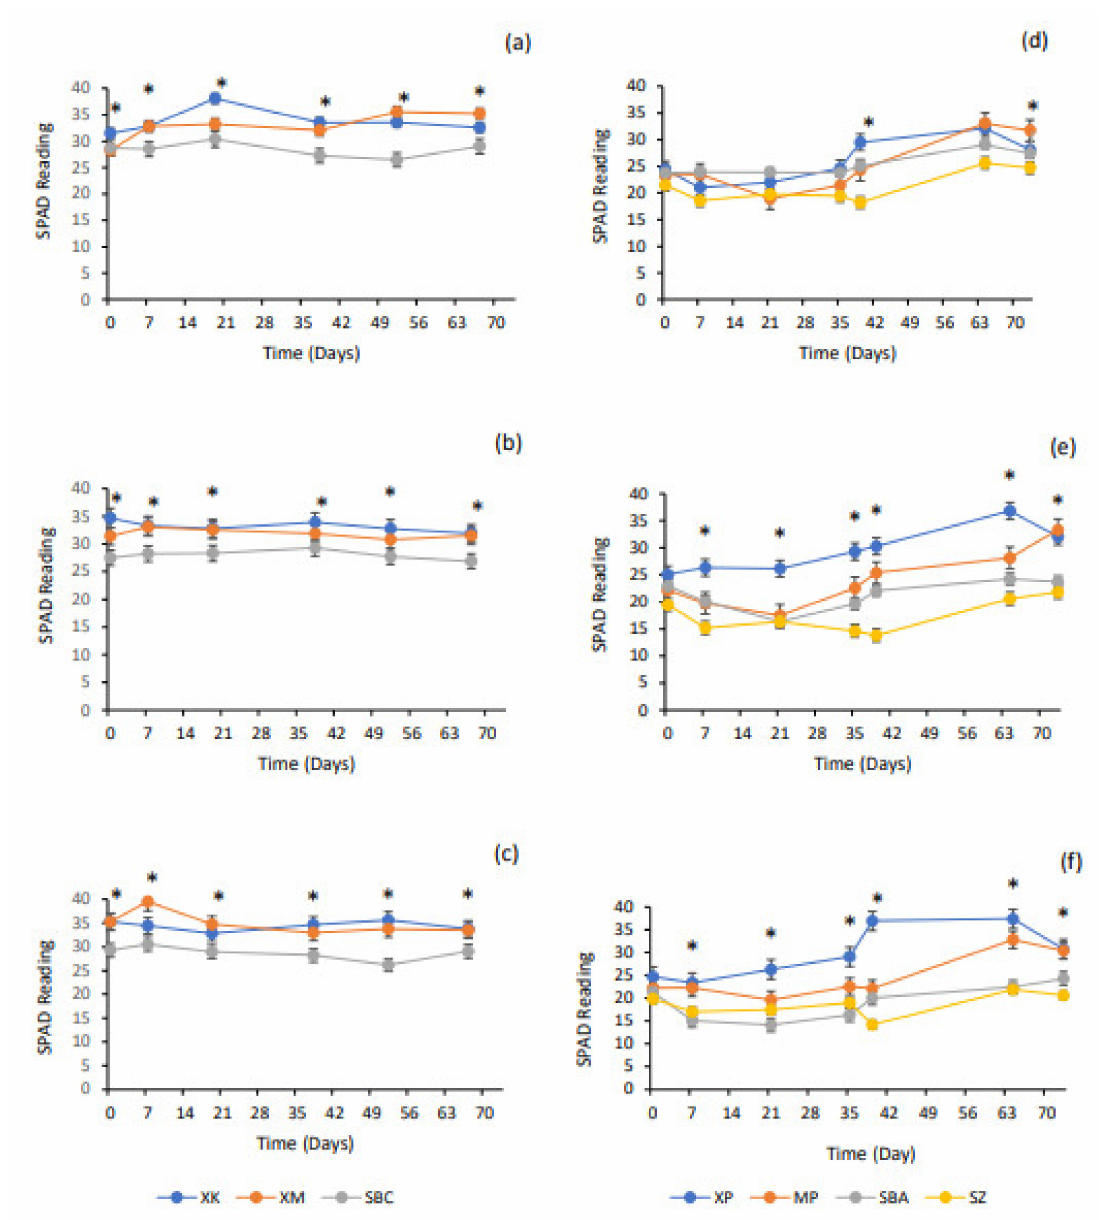
Figure 8. SPAD reading (indicative chlorophyll content) measures in potted trials for seasons 2019 and 2020/2021. XM—Xynisteri Mandria, XK—Xynisteri Kathikas, XP—Xynisteri Paphos,